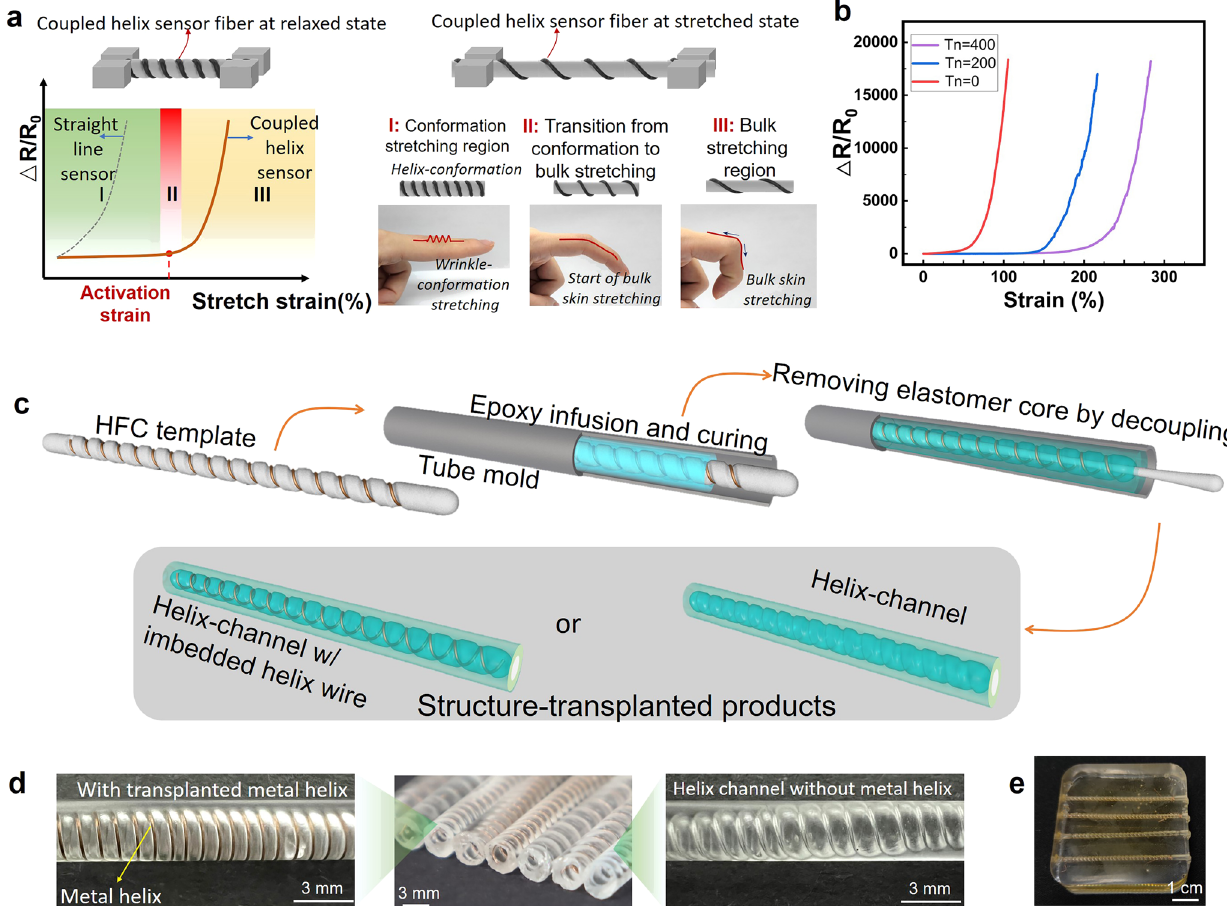
Fig. 5 Demonstration of HFC as an innovation platform for the design and fabrication of helix-structured functional composites. a Illustration of HFC- based biomimetic smart sensor with helix-conformation structure for realizing programmable activation strain for unique sensing application. The conformation change behavior of fi nger skin during fi nger motion is also demonstrated to help the understanding of the helix-conformation change of the sensor fi ber mechanically coupled with the elastomer core. b The unique strain sensor properties of HFC and the regulation of the activation strain for the HFC sensor materials by the torsion number, T n , respectively. c Illustration of the concept of structure-transplantation by stretching-based mechanical decoupling operation of the HFC. d Photographs for the structure-transplanted tube products from the HFC, with or without the transplanted metal helix. e Photograph of an epoxy cuboid with metal-helix array structure by HFC-based structure